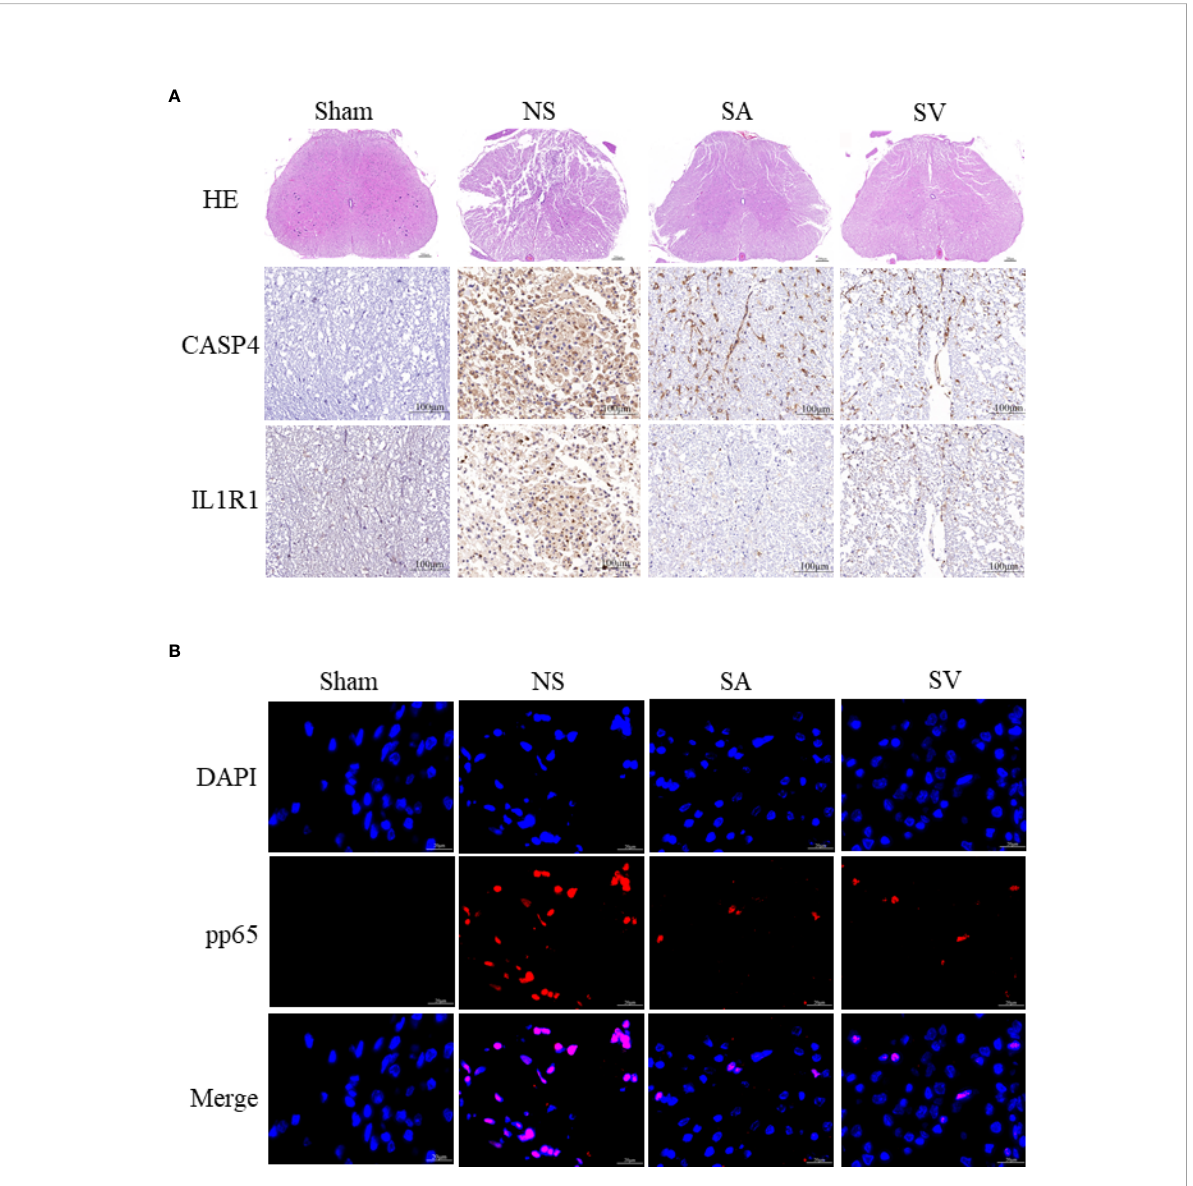
FIGURE 7 Histopathological changes. (A) HE staining demonstrated that the structure of the injured spinal cord tissue became clearer after treatment, with fewer cavities and necroses as compared with SCI group (Scale bars = 100 m m, the arrows point to cavities and necroses), and the expression level of the biomarkers in the spinal cord was reduced (Scale bars = 20 m m) (n = 3 rats per group, *p < 0.05, **p < 0.01, ***p < 0.001, t-test). (B) Representative images showing pp65 and DAPI co-staining of the spinal cord sections from the rats of the four groups (Scale bars = 20 m m) (n = 3 rats per group, *p < 0.05, **p < 0.01, ***p < 0.001,